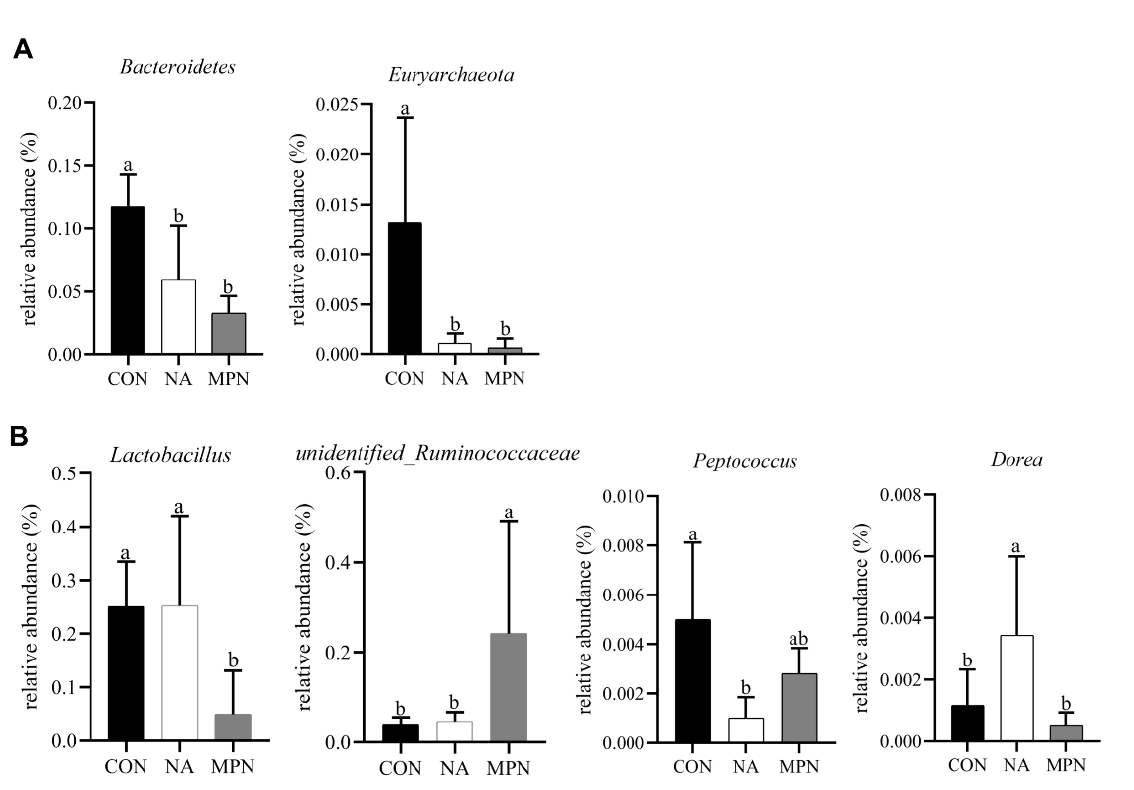
Figure 6. Effects of niacin on the relative abundance of intestinal bacteria in weaned piglets. a, b Values of different superscripts in the same row mean significantly different ( p < 0.05). Values are expressed as the mean ± SD, n = 8/treatment. Comparison of differential colonic microbiota at the phylum ( A ) and genus ( B ) levels. CON, control group; NA, niacin group; MPN, GPR109A antagonist group.